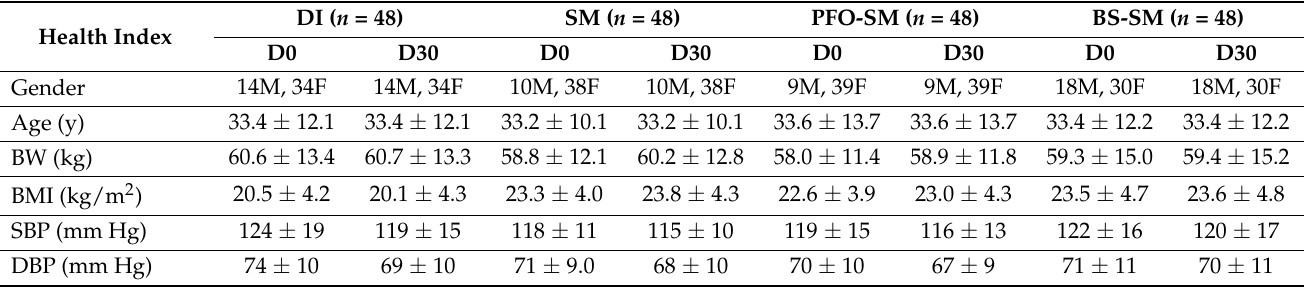
Table 4. Information and health outcomes of subjects enrolled in this study. Participants consumed DI, SM, PFO-SM, or BS-SM twice daily for 30 days. BW, BMI, SBP, and DBP values were then recorded. Data are expressed as mean ± SD